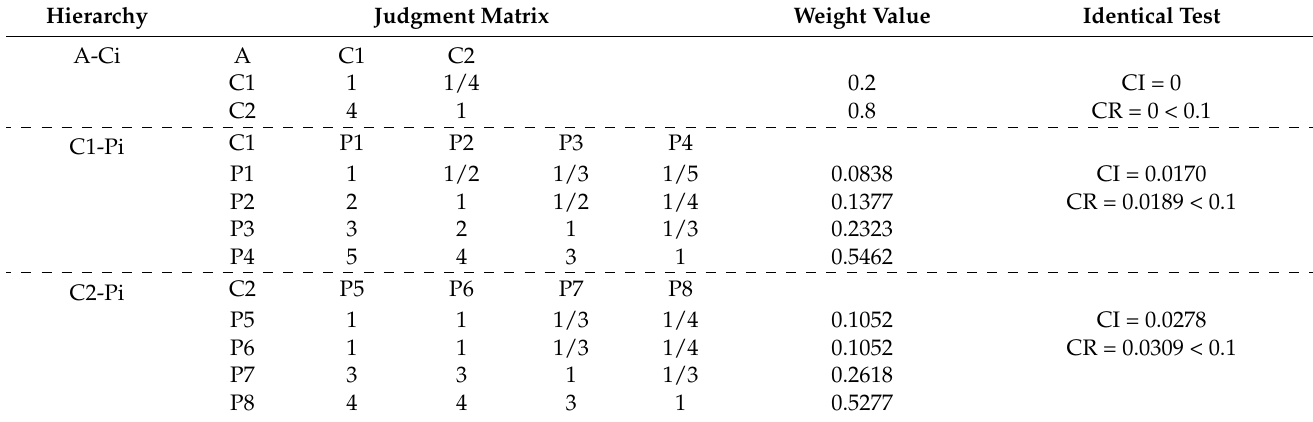
Table 3. Comprehensive evaluation judgment matrix, weight value and identical test.